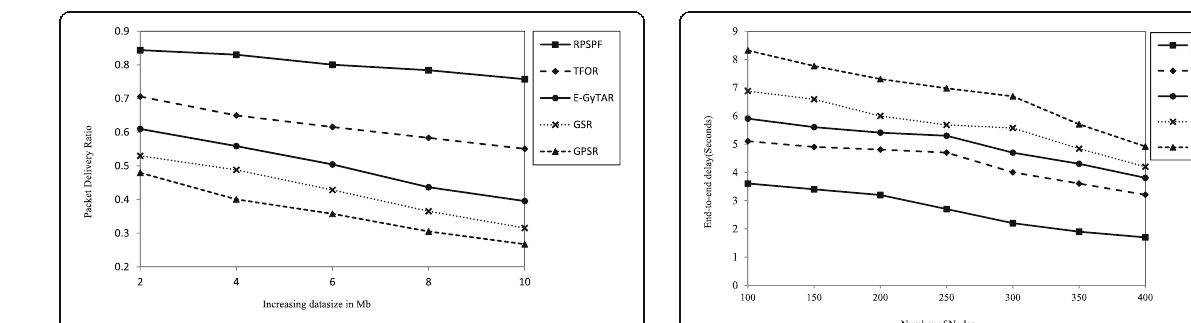
Fig. 7 Influence of increasing data size on packet delivery ratio (400 nodes). RPSPF represents Reliable Path Selection and Packet Forwarding Routing Protocol which is proposed approach and is represented by a solid line with a square. TFOR is traffic flow- oriented routing protocol and is represented by a dashed line having rhombus. E-GyTAR is Enhanced Greedy Traffic Aware Routing protocol and is represented by a solid line with circle. GSR is geographic source routing protocol and is presented by a dotted line having a cross. GPSR is Greedy Perimeter Stateless Routing Protocol and is presented by a dashed line having a